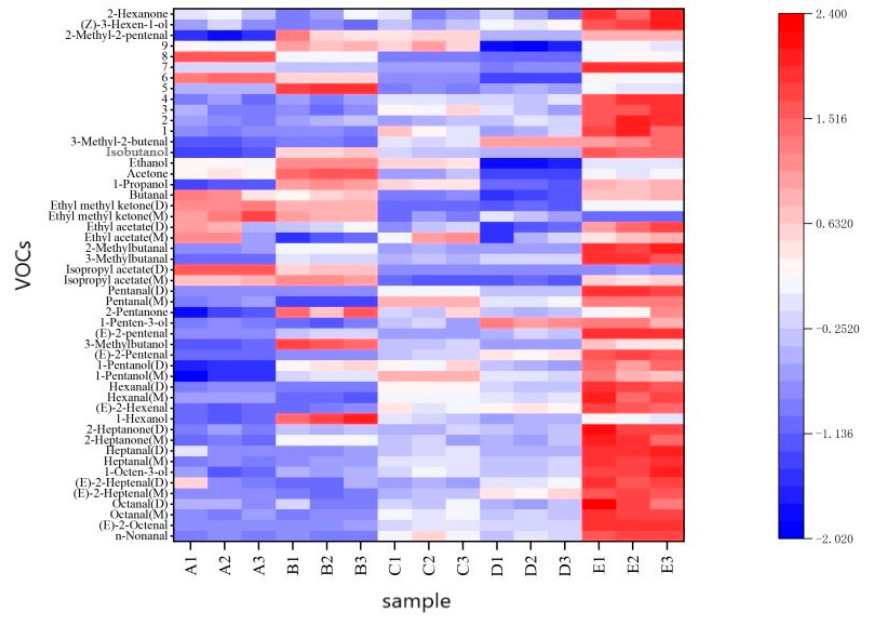
Figure 4. Heat map of VOCs in walnut oil from five different varieties.